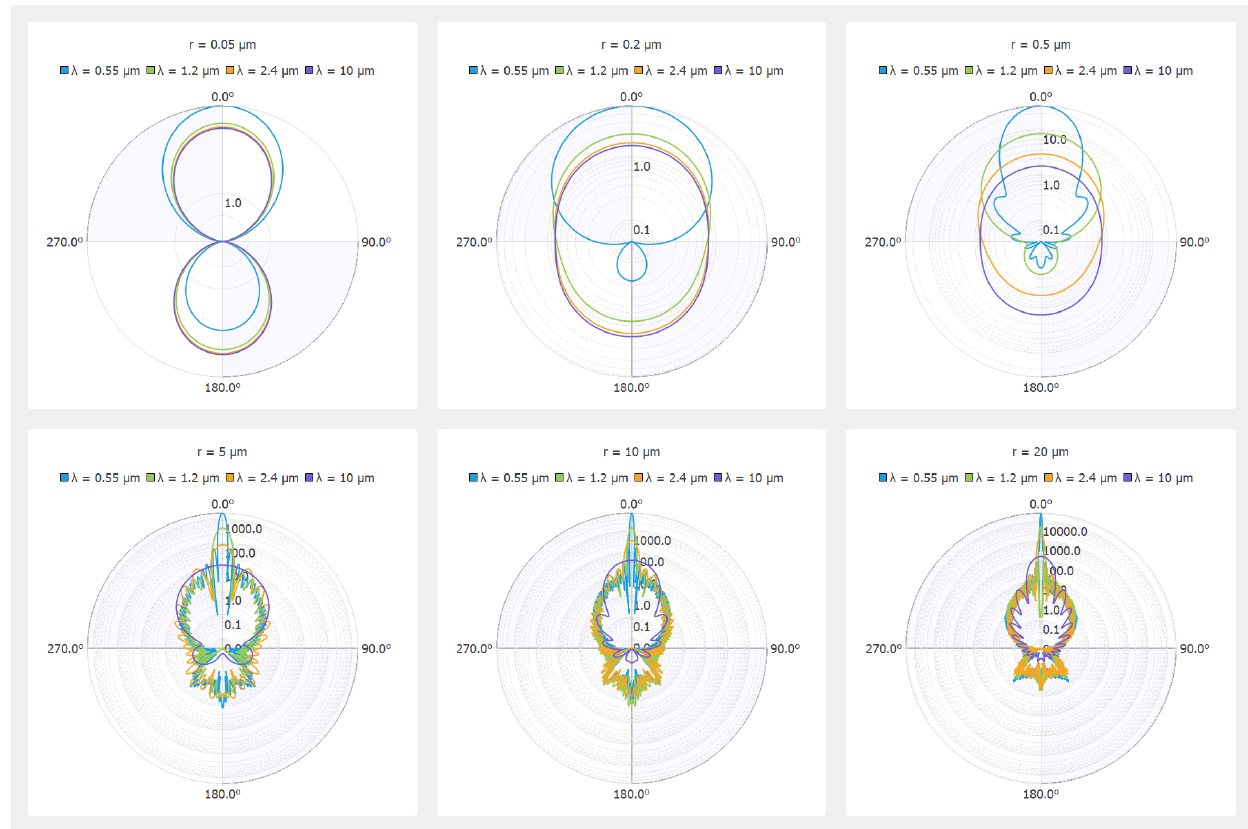
Figure 1. Polar representation of the phase function for six radii (r) of spherical particles and different wavelengths ( λ